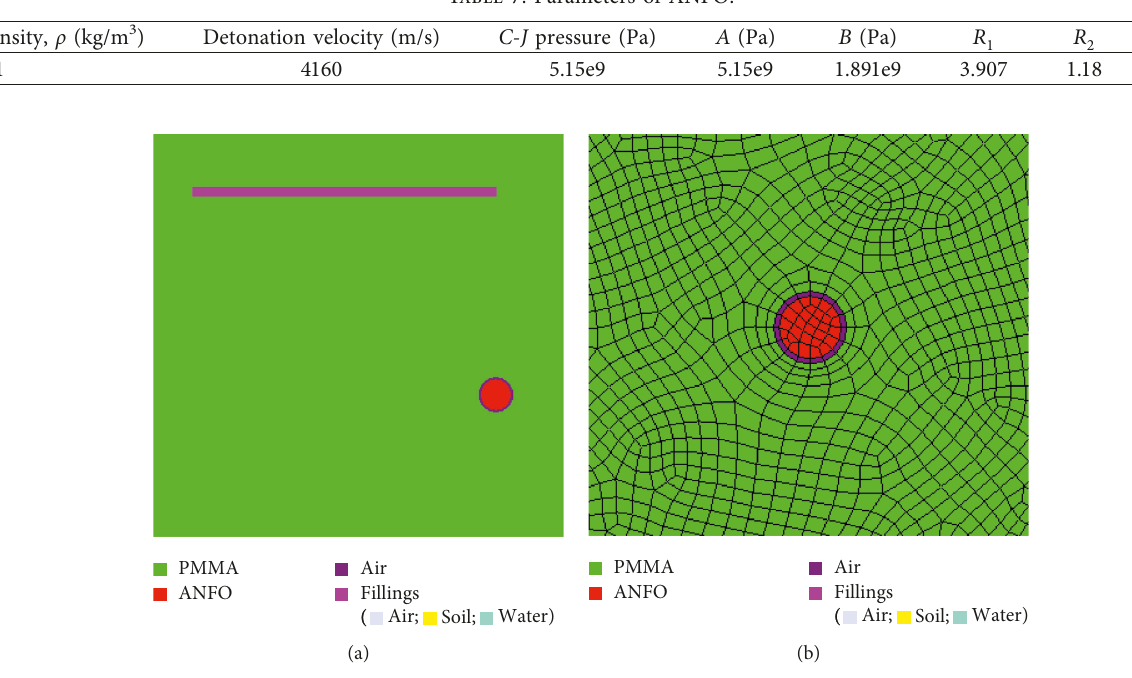
Table 7: Parameters of ANFO.